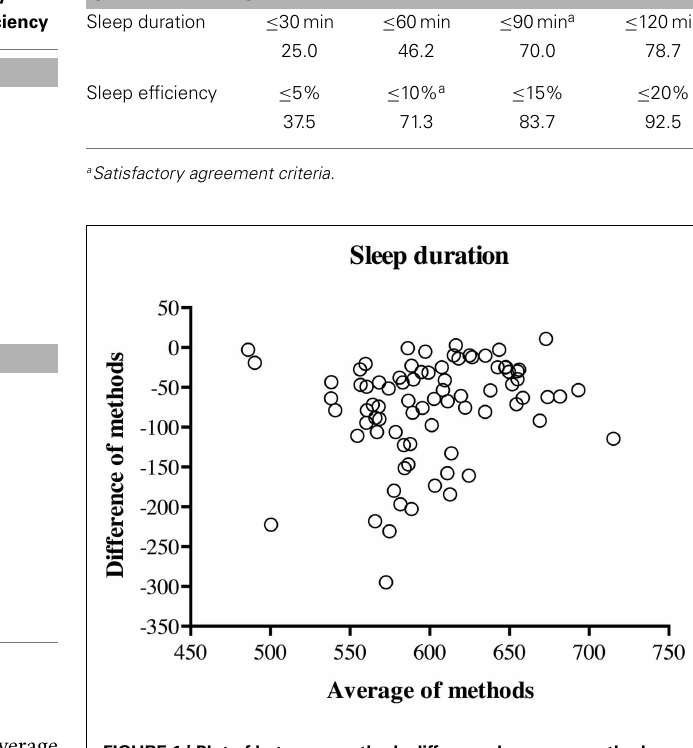
most mothers (63.8%) reported no awakening in the diary.